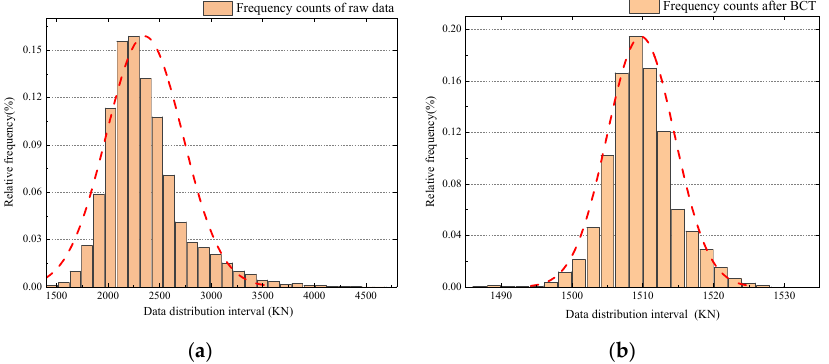
Figure 11. The comparison of data distribution between the raw data and transformed data. ( a ) Fre- quency counts of the raw data (skewness = 1.274); ( b ) frequency counts after the BCT (skewness = 0.101).